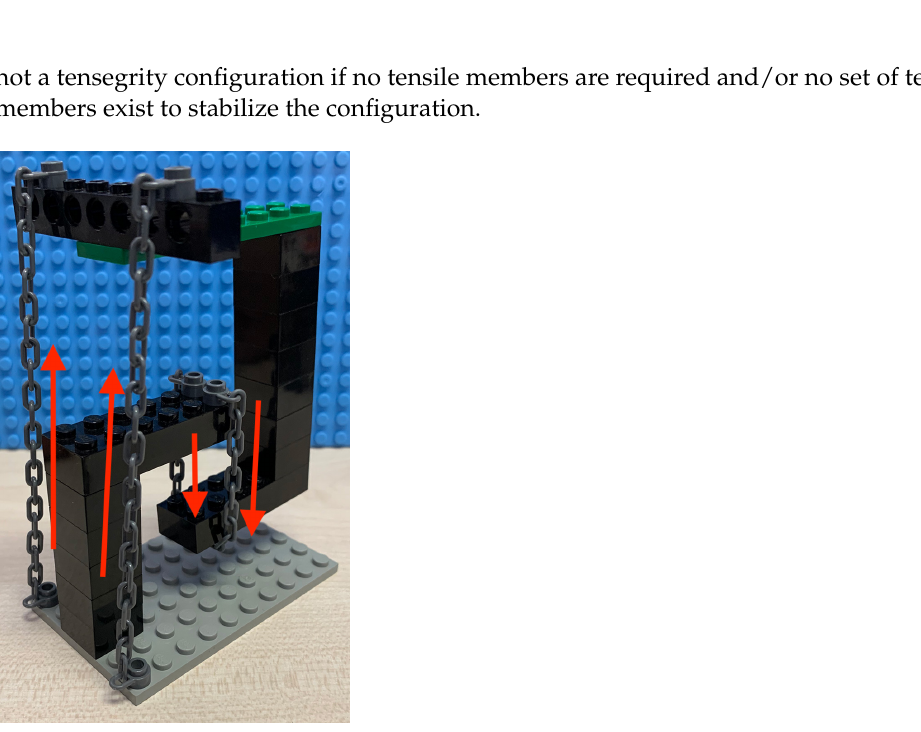
Figure 1. An example of a tensegrity structure formed with LEGO. The blocks are rigid bodies, and the chains are tensile members. The red arrows indicate the directions of the forces on the chains.